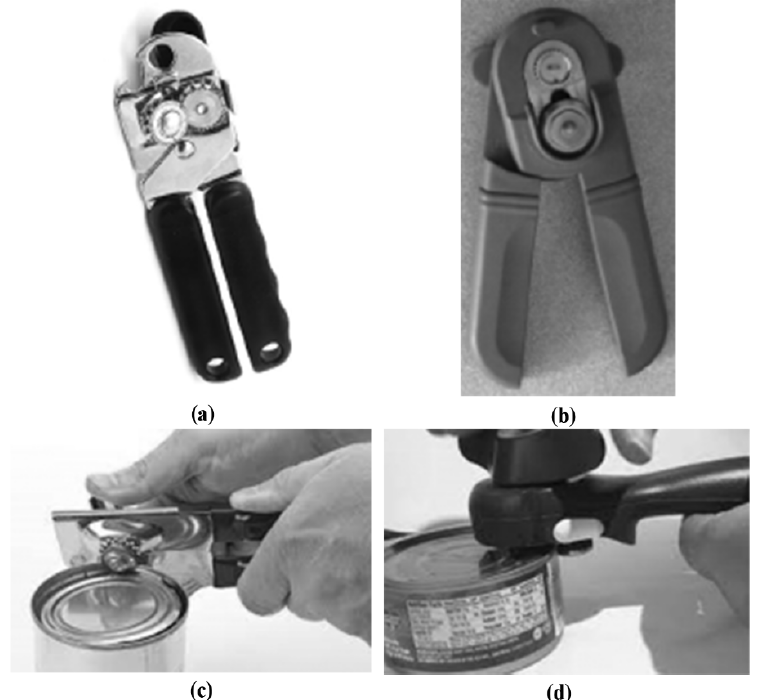
Figure 1. Design and use of a side cutting can opener ( a , c ) and a top cutting opener ( b , d ). Modified after ( a ) Evan-Amos, Public domain, via Wikimedia Commons, ( b ) © Materialscientist at English Wikipedia, CC BY-SA 3.0 https://creativecommons.org/licenses/by-sa/3.0 (accessed on 1 February 2022) via Wikimedia Commons, ( c ) © Whitestar1955|Dreamstime.com https://koit.com/96-5-koit-